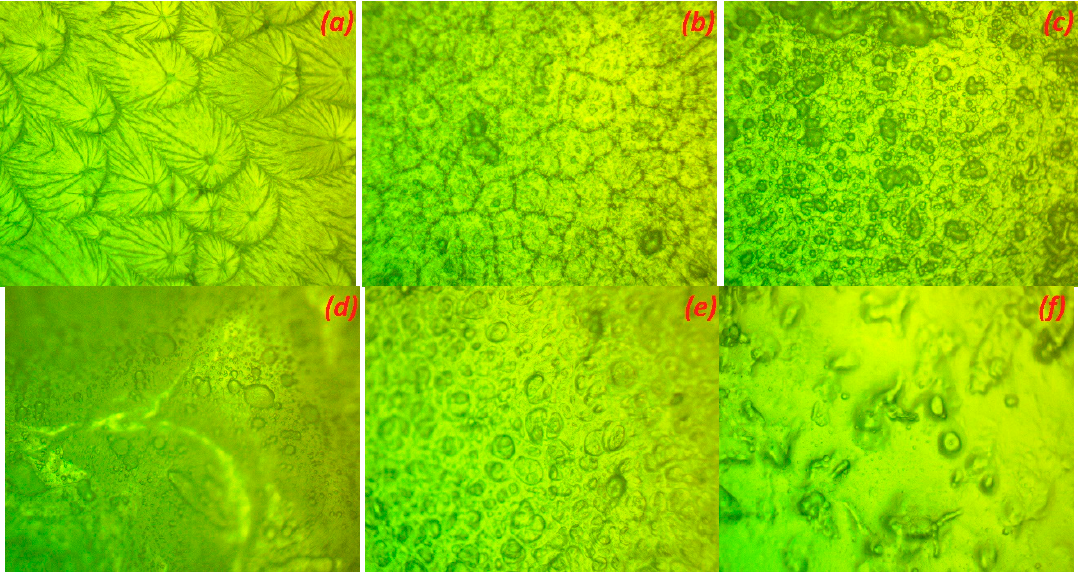
Figure 4. The FTIR spectra for: (a) Pure PEO; (b) PEO:MC blend weight ratio 80:20; (c) PEO:MC blend weight ratio 60:40; (d) PEO:MC blend weight ratio 40:60; (e) PEO:MC blend weight ratio 20:80; (f) Pure MC.